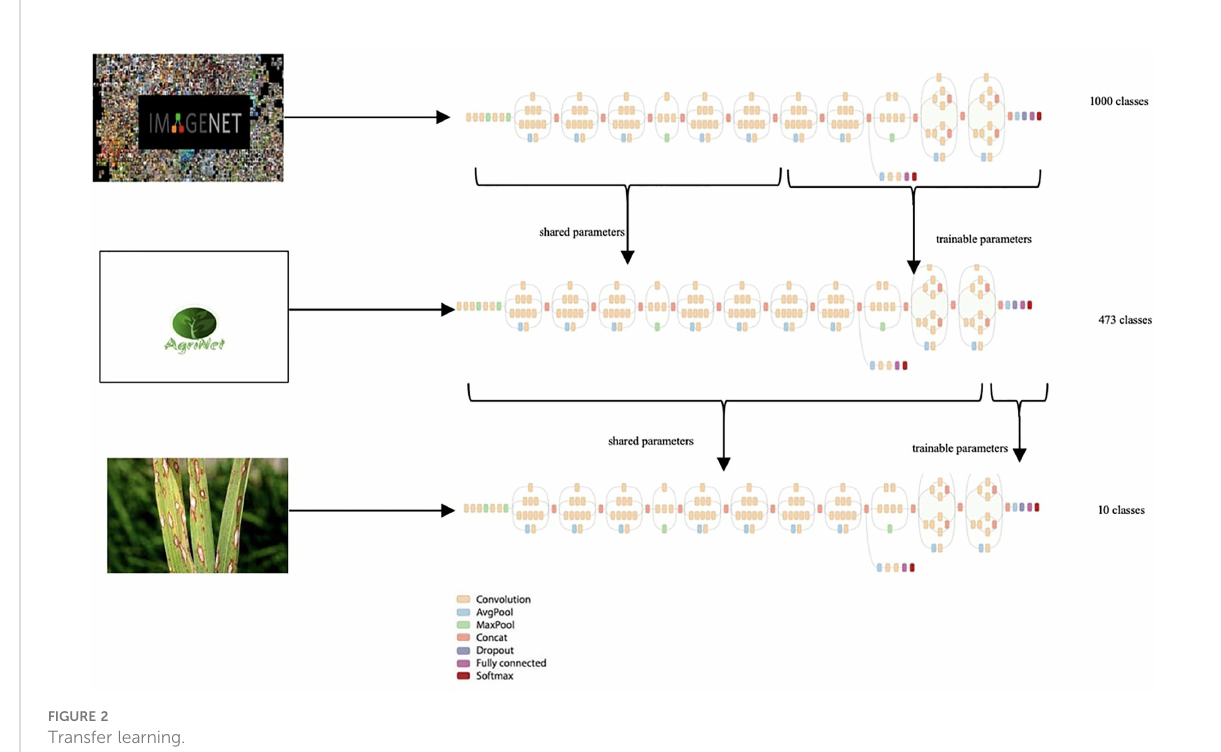
FIGURE 2 Transfer